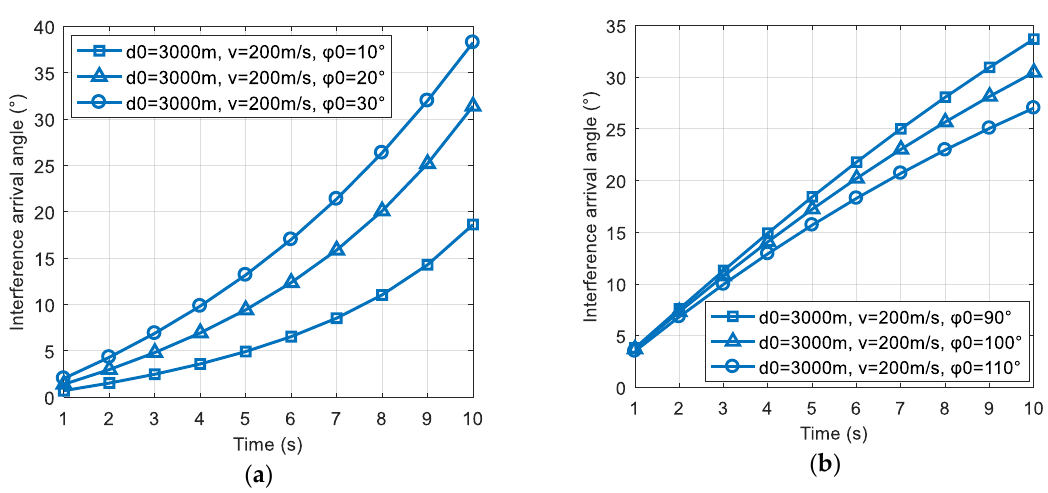
Figure 4. The change of the interference direction with the relative motion direction φ change of the interference direction in the case where